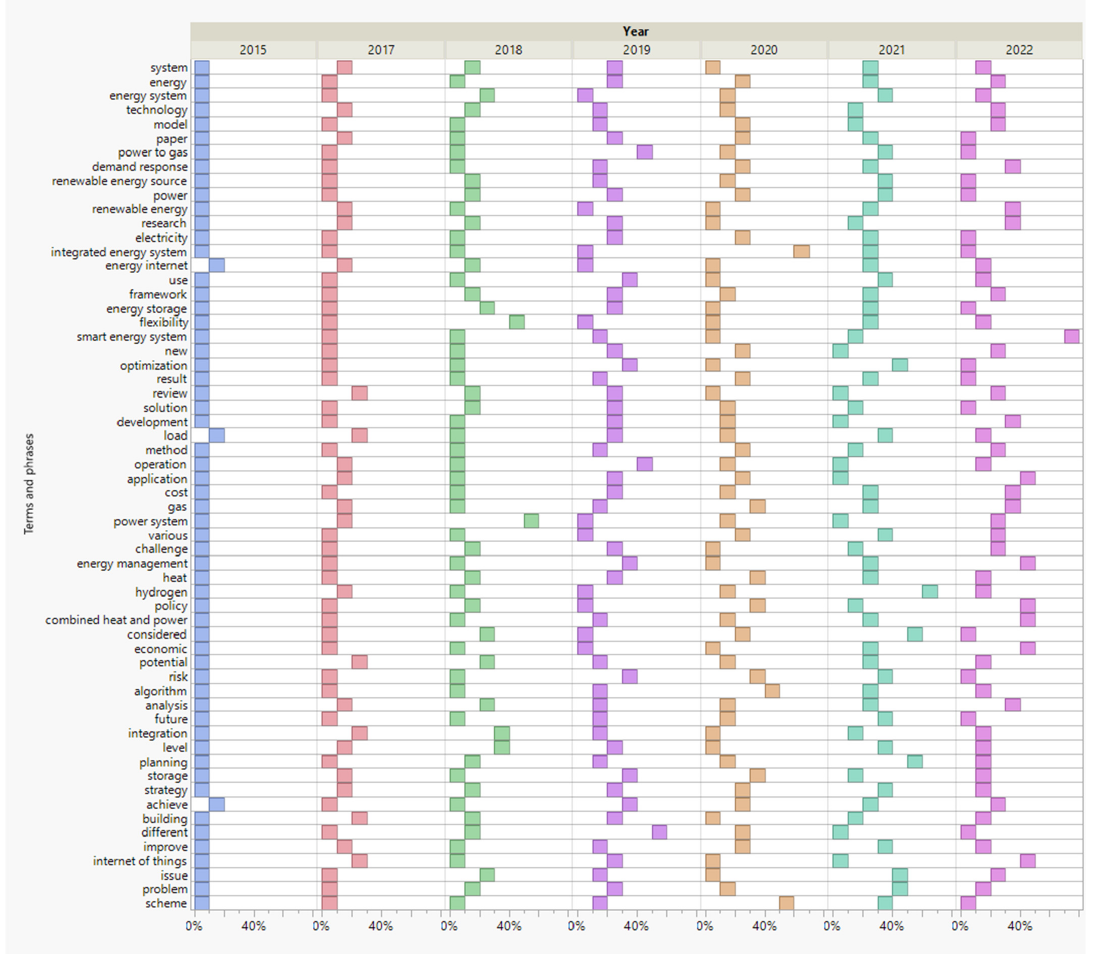
Figure 3. Rate of appearance of most common terms in the selected elements regarding their time of publication (own construction). publication (own